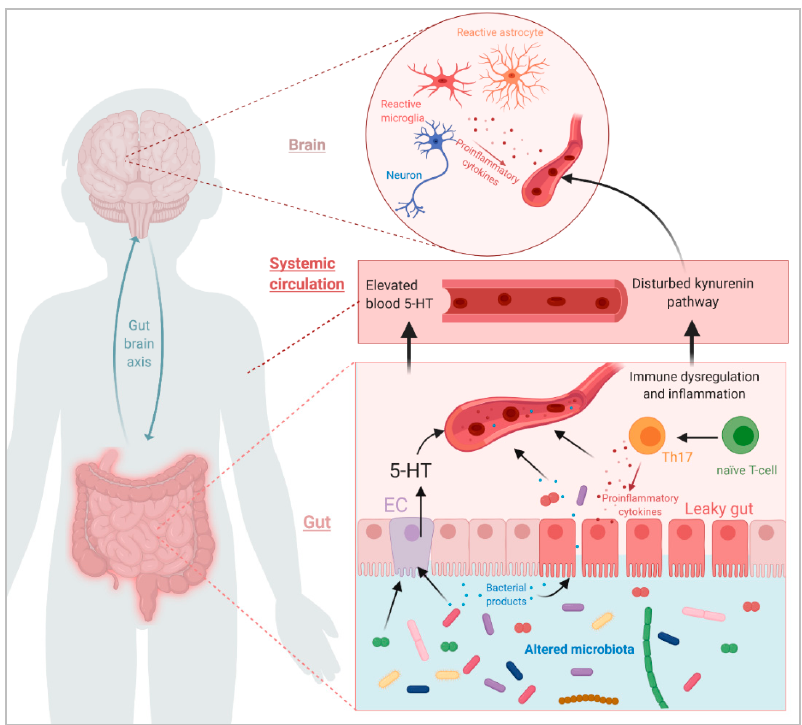
Figure 1. Summary schematic showing the potential impacts of a disturbed gut microbiota on various parameters in the gut, systemic circulation and brain in ASD, and how those parameters can be linked. (Figure created with BioRender.com).